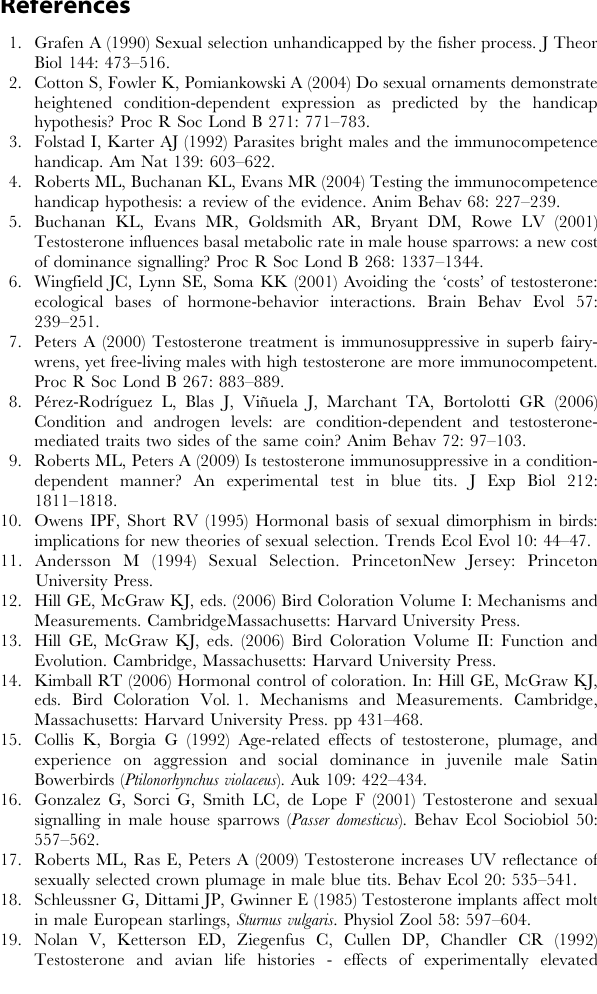
recapture. Figure S2 Changes in body condition of testosterone, control, and after-second year males. Changes in mean residual body condition 6 SE at implantation, the mid-treatment recapture, implant removal, and the post-treatment recapture. Figure S3 Reflectance of testosterone, control, and anti- testosterone back (A), breast (B), and crown (C) feathers. Lines indicate mean reflectance from testosterone (T, N= 6), control (N = 6), and Anti-T males (N= 5) from whom feathers were collected at implant removal. Figure S4 UV chroma of testosterone and after-second year male breast feathers. Mean UV chroma 6 SE of breast feathers collected at implant removal from T (N = 6) and ASY males (N =4). Figure S5 Plasma luteinizing hormone (LH) concentra- tions of testosterone, anti-testosterone, control, and after-second year males. Bars indicate treatment mean LH